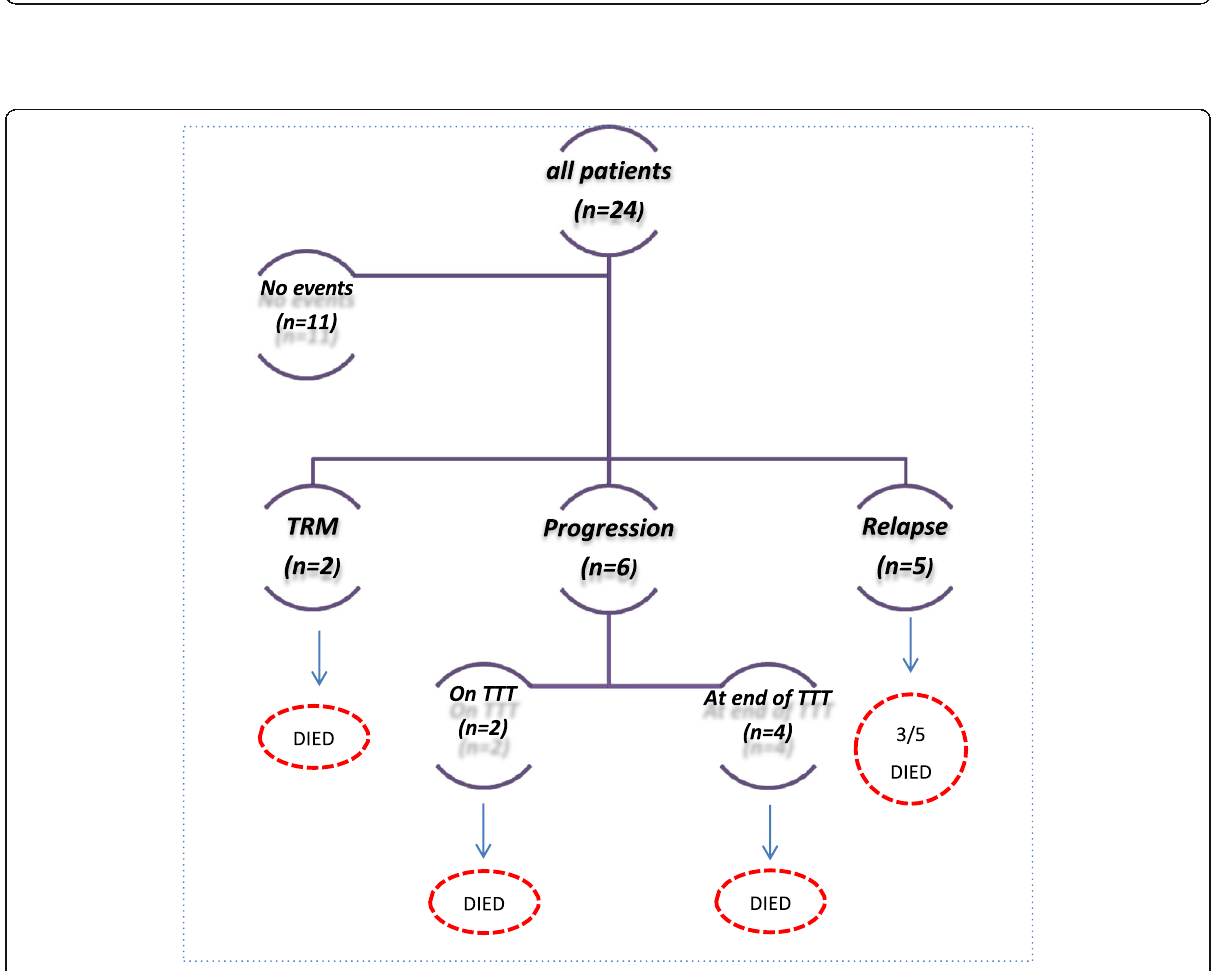
Fig. 3 Initial management and local staging of study patients. CTH, chemotherapy; SM, surgical margin; LNs, lymph nodes. *: including the patient with tumor rupture